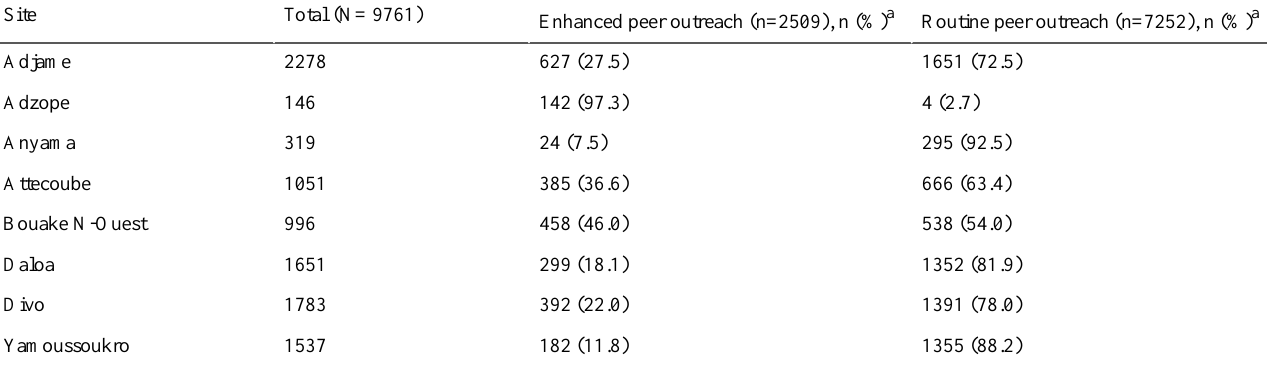
Table 3. Geographic distribution of a sample of female sex workers reached by enhanced peer outreach approach and routine peer-based outreach strategies in Côte d’Ivoire between October 2017 and April